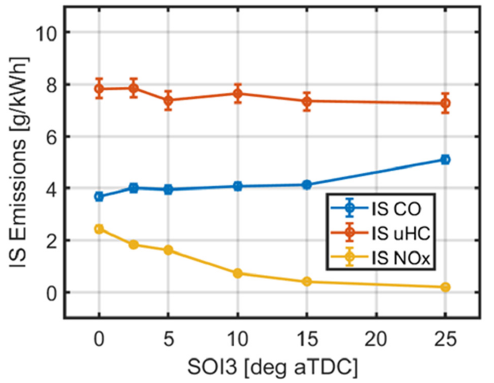
Figure 6. Indicated specific emissions of CO (IS CO), IS uHC, and IS NOx vs. mixing-controlled start of injection (SOI3) timing.